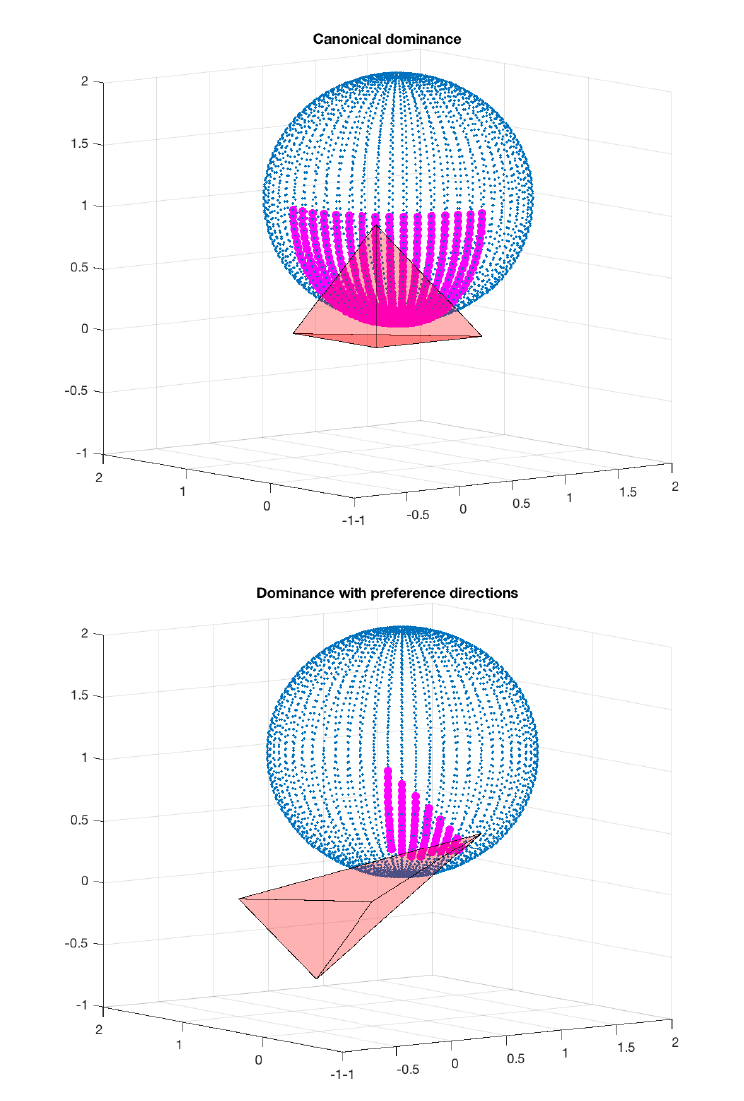
Figure 6. 3D Pareto front approximation (in magenta) with canonical dominance ( upper figure) and dominance with preferences ( bottom